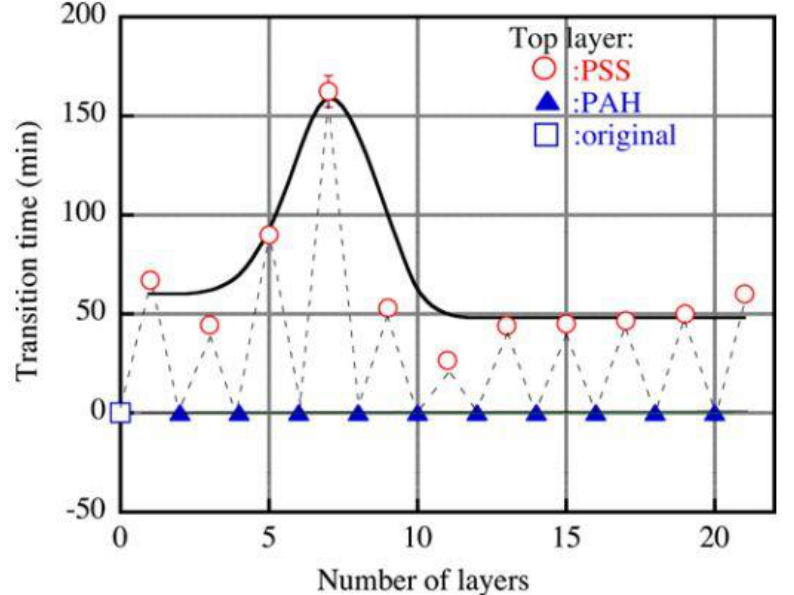
Figure 12. Effect of the number of layers on the transition time (in this case, the time elapsed before the onset of fouling). The feed solution contained 0.05 M NaCl and 0.052 kg/m 3 SDBS. Squares represent the original membrane, circles represent the membrane terminated with PSS (polystyrene sulfonate), and triangles represent the membrane terminated with PAH (polyallylamine). The modification solution contained 0.3 kg/m 3 of PSS or PAH, and 1 M NaCl. Reprinted with permission from Ref. [93]. Copyright © 2012 Elsevier B.V.